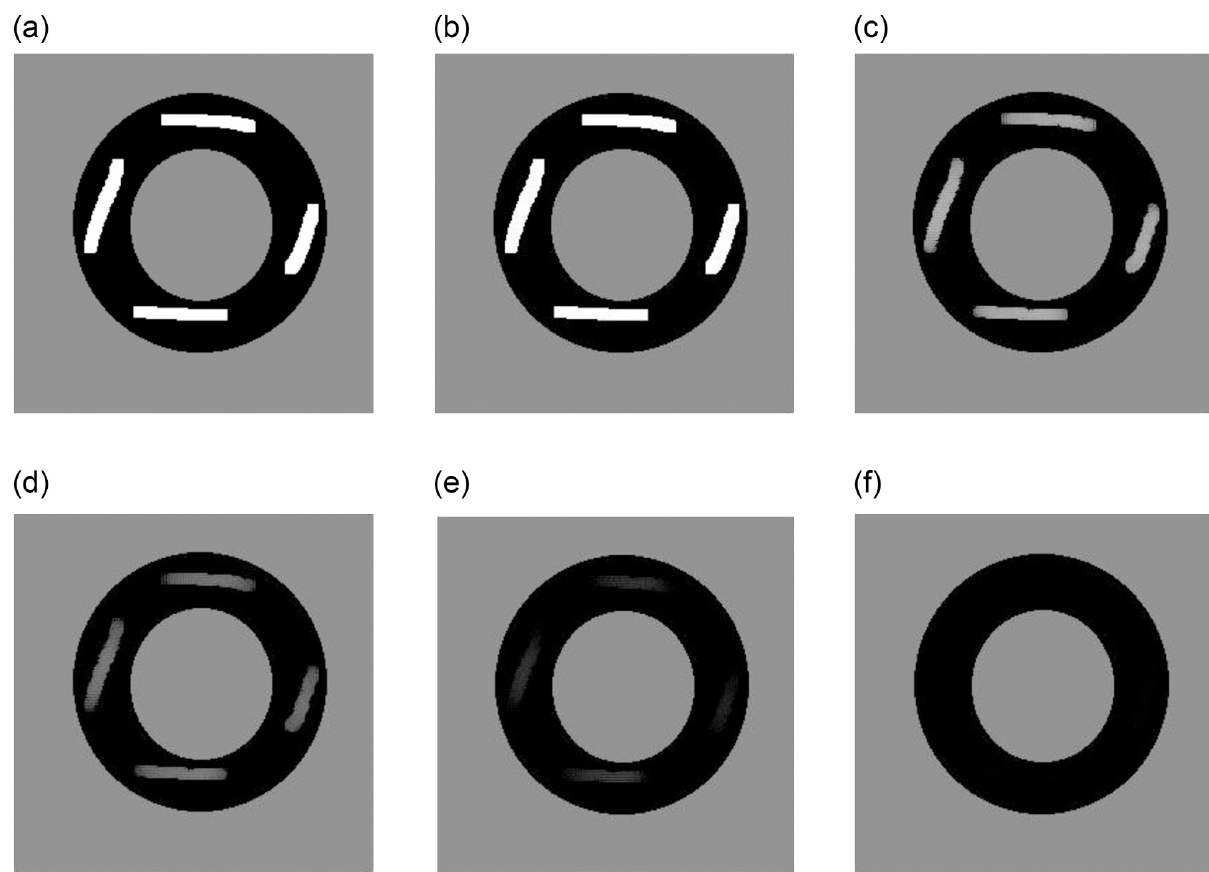
Fig 2. The inpainting results for synthetic images. (a) is the original broken picture, (b) to (f) is the results of 100, 200, 300, 400, 500 iterations.